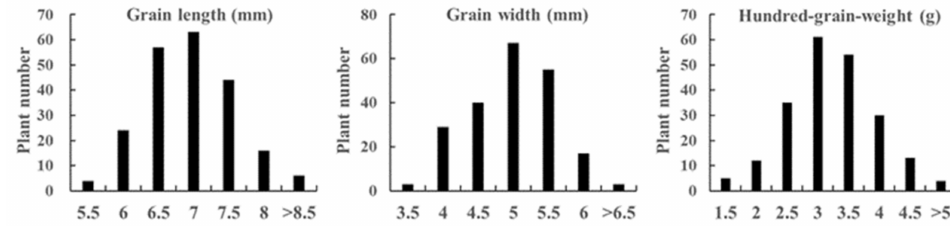
Figure 2. The frequency distribution of grain size traits in the F 1